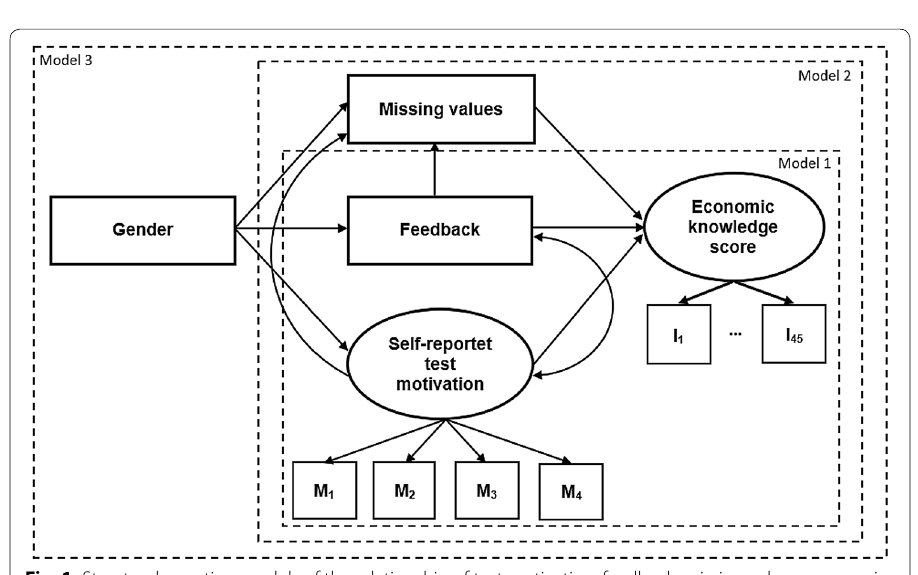
Fig. 1 Structural equation models of the relationship of test motivation, feedback, missing values, economic knowledge as test performance and